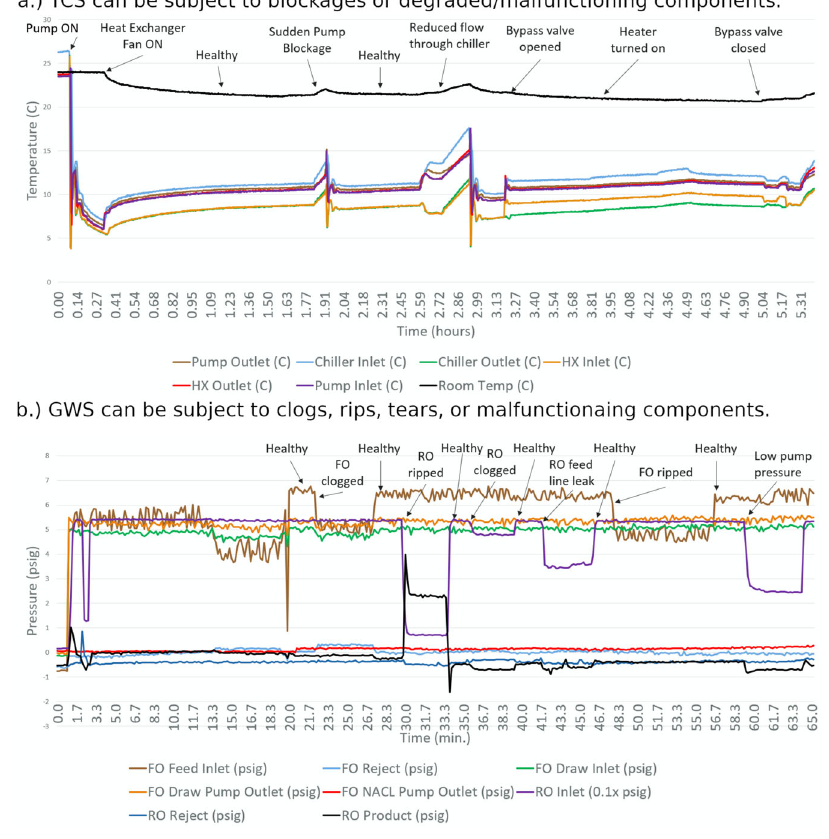
Fig. 4 Experimentally captured data from the mock space habitat illustrate the operation during normal and faulted conditions. a Normal and faulted operation is shown for a variety of faults emulated in the TCS. b Pressures throughout the GWS change in response to normal and faulted